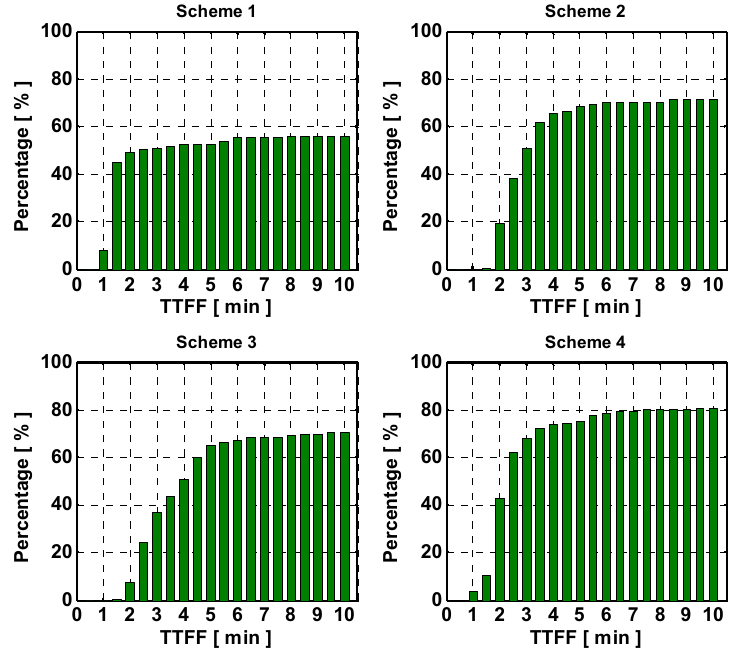
Figure 8. Cumulative distribution of TTFF of the network with long inter-station distance. The panels from top-left to bottom-right indicate the results with respect to Schemes 1 to 4.